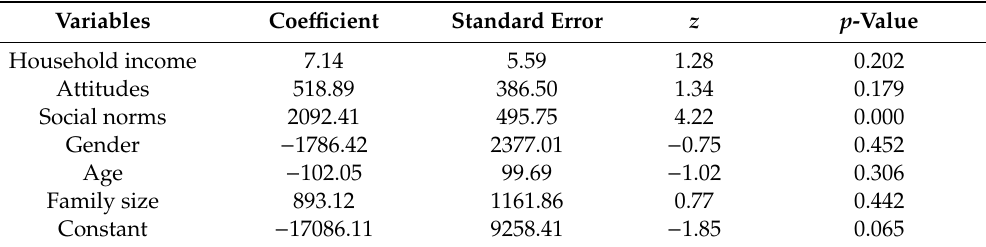
Table 7. Estimated parameters for the double-bounded choice model for IAA fish.